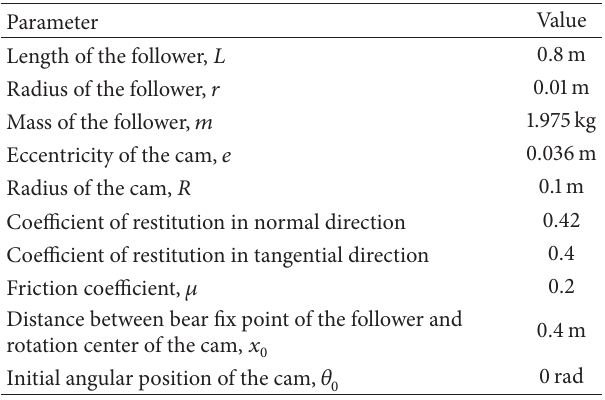
Table 1: Cam-follower oblique-impact numerical simulation